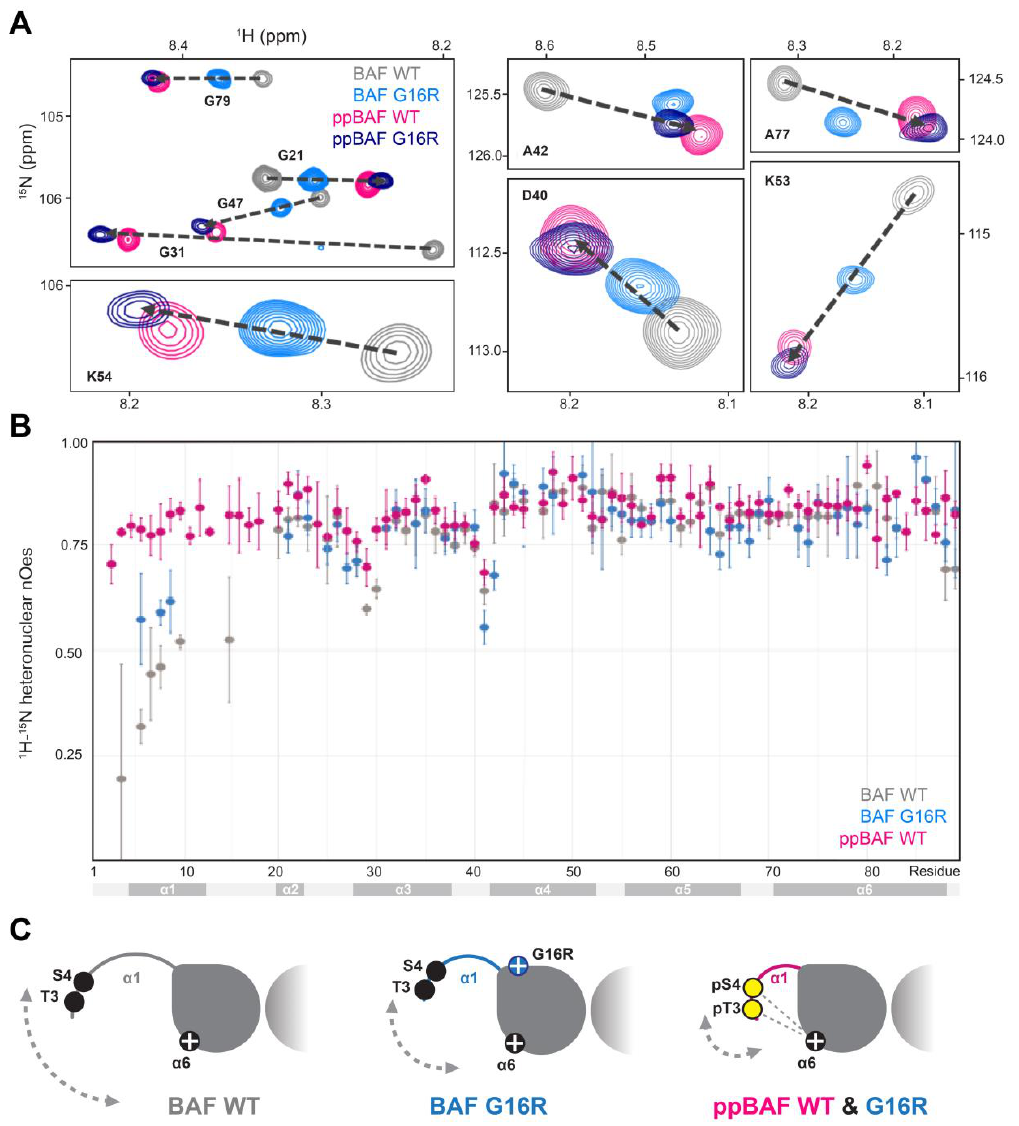
Figure 3. The Gly16Arg mutation modifies solution conformations of BAF by reducing flexibility of the amino terminus. ( A ) Zoomed-in views of the superimposition of the 2D NMR 1 H- 15 N HSQC spectra of BAF WT (in grey), BAF Gly16Arg (in cyan), di-phosphorylated BAF WT (in hot pink), and di-phosphorylated BAF Gly16Arg (in dark blue). Full views are displayed in Supplementary Figure S1C. The NMR signals of the four species are aligned, showing that they are all exchanging between the same two ensembles of conformations, defined as open and closed states in [22,32]. ( B ) Plot of the NMR 1 H → 15 N nOe values as a function of the residue number (BAF WT: grey; BAF Gly16Arg: cyan; di-phosphorylated BAF WT: hot pink). These values reflect the dynamics on a fast (picosecond to nanosecond) timescale of the amide bonds of BAF residues. Low and high values indicate flexibility and rigidity, respectively. ( C ) Scheme illustrating that BAF Gly16Arg exhibits an N-terminal region fluctuating between open and closed conformations, which is positioned more often in a closed conformation when compared to BAF WT, but more often in an opened conformation when compared to di-phosphorylated BAF WT. The more rigid helix α 1 region of BAF Gly16Arg compared to WT is indicated by a bold blue line, whereas the salt-bridges restraining the position of the N-terminus relatively to helix α 6 in di-phosphorylated BAF WT and Gly16Arg are marked with dotted lines.